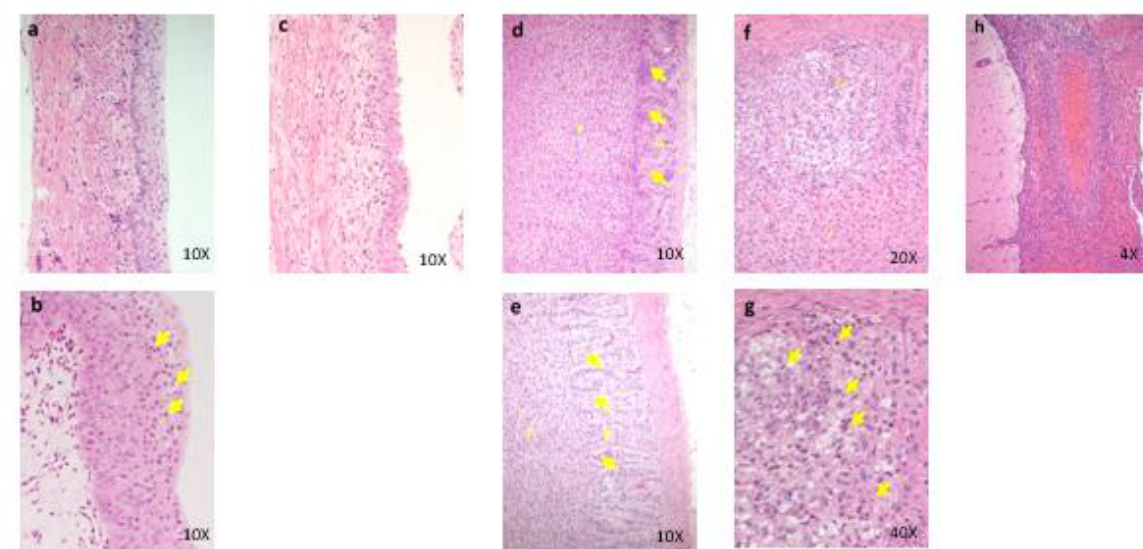
Figure 4: Histopathological findings in renal pelvis in kidney. control (a), 100 mg/kg (b), 600 mg/kg (c), a , No abnormalities detected. b , Many necrotic cells (arrows) are seen in the mucosa. c , Thinning of the mucosal epithelium. Histopathological findings in adrenal. control (d), 600 mg/kg (e)(f)(g), d , No abnor- malities detected, e , Hypertrophy of the cortical cells at glomerulosa/fasciculate boundary (arrows) are seen. f, g , Necrosis and degeneration of the glomerulosa cells are seen. Degenerative cells show vac- uolated cytoplasma. Many necrotic cells (arrows) are also seen in the same lesion. g: zona glomerulosa, f: zona fasciculate, arrows: glomerulosa/ fasciculate boundary. Histopathological findings in brain. 600 mg/kg (h), h, Inflammatory cells infiltration and hemorrhage are seen in the